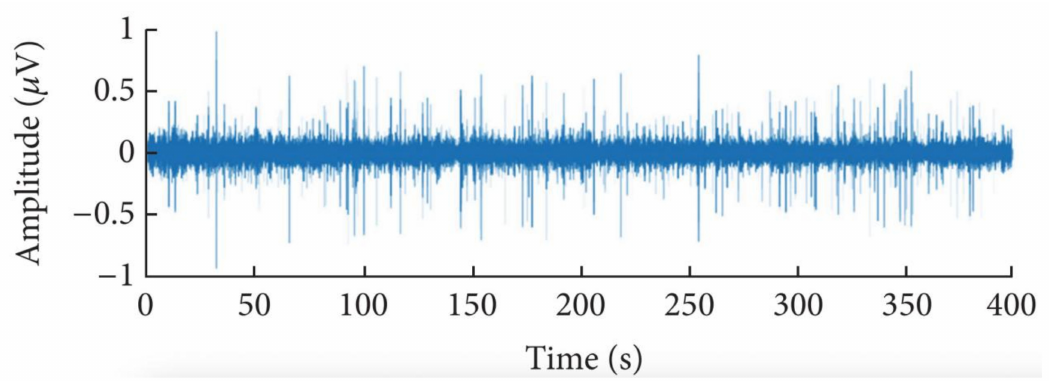
Figure 6. A time domain diagram of underwater noise.